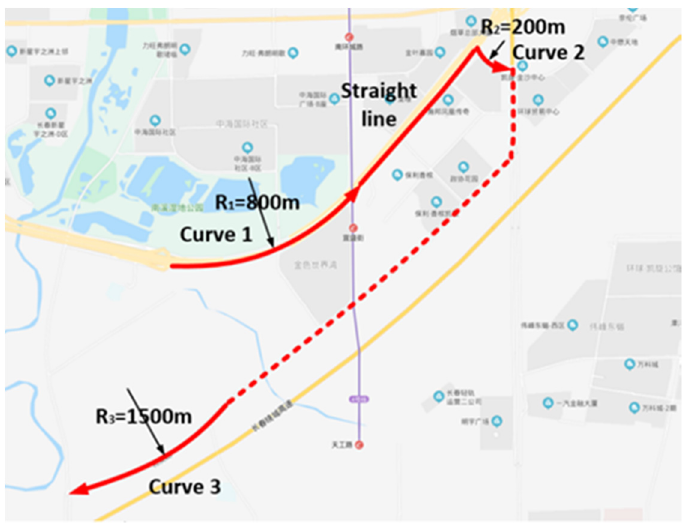
Figure 2. Experimental route.